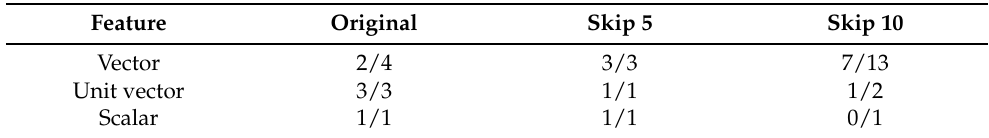
Figure 8. Global ID-matching accuracy with ( a ) 3 cameras (cameras 1, 2, and 3), and ( b ) 4 cameras. Table 5. Ratio of errors due to Re-ID to the total number of failures for global tracklet matching in the experiment with four